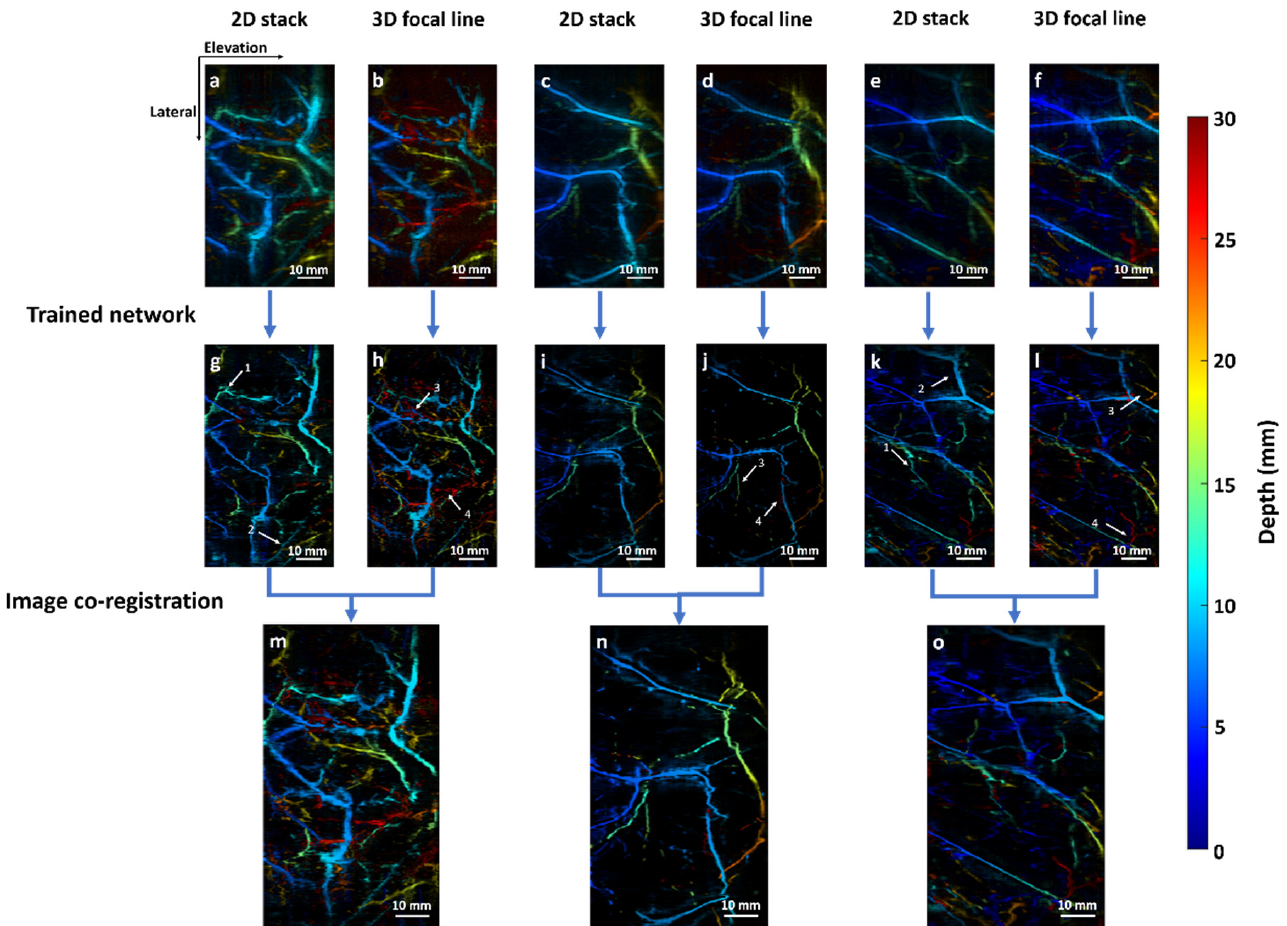
Figure 7. In vivo validation using human breast data. ( a , c , e ) 2D stack reconstructed images from three subjects, respectively. ( b , d , f ) 3D focal-line reconstructed images from the three subjects, respectively. ( g , i , k ) Output images from 2D Deep-E. ( h , j , l ) Output images from 3D Deep-E. ( m , n , o ) Final output after image co-registration. The color bar represents depth ranges from 0 to 30 mm.